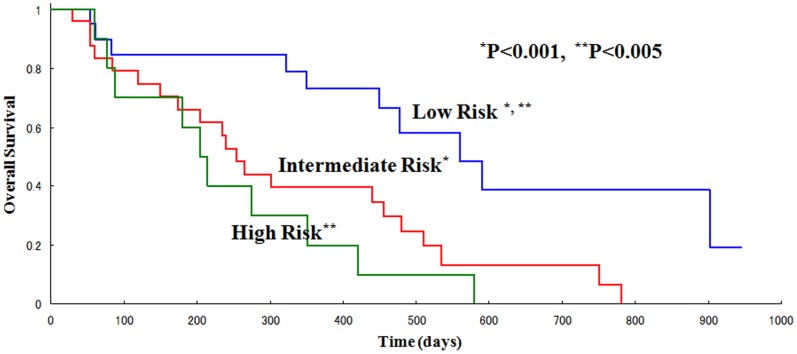
Overall survival in each risk group with long-term treatment.The low risk group showed significant differences compared with the intermediate and high risk groups (P<0.005 and P<0.001, respectively).